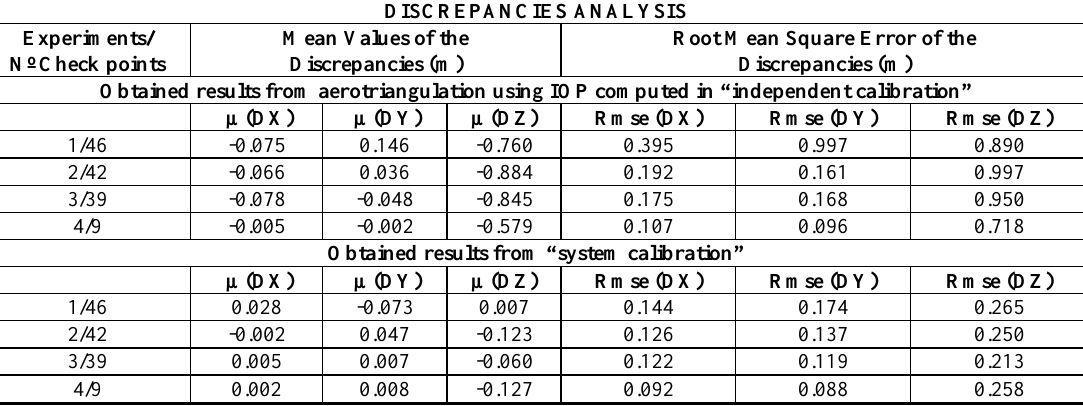
Table 5. Main results of the discrepancies analysis performed in the experiments with aerotriangulation and system